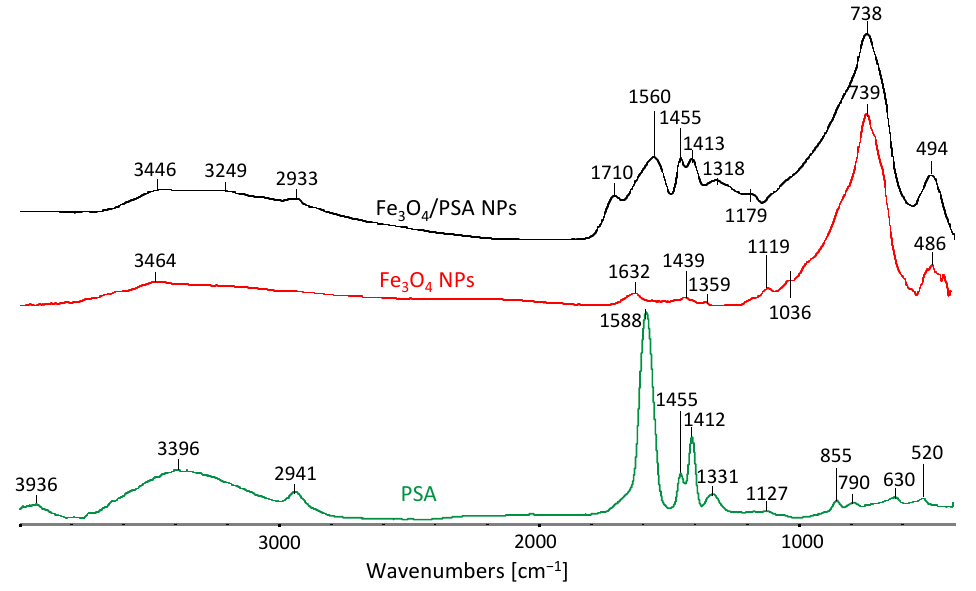
Figure 3. FTIR spectra of polymer (PSA), unmodified magnetite (Fe 3 O 4 NPs), poly(sodium acrylate)- modified magnetite (Fe 3 O 4 /PSA NPs).